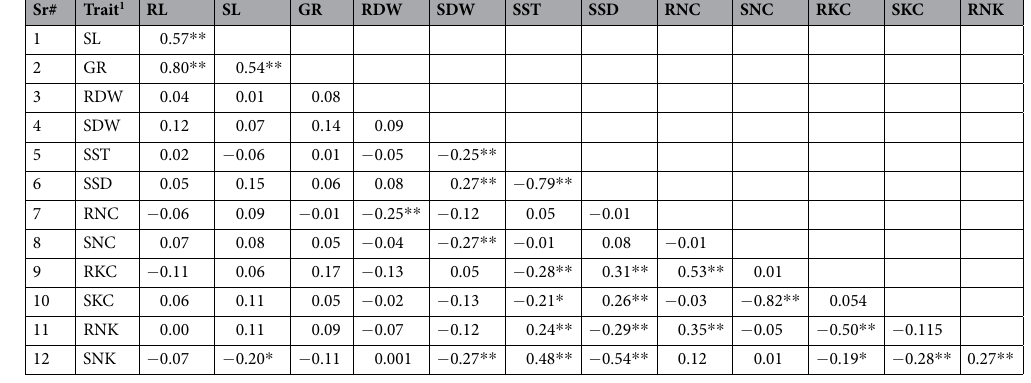
Table 2. Pearson’s co-efficient of correlation for salt tolerance related traits measured at the germination and seedling stages under salinity. 1 Same as in Table 1. * and ** represents significance at P < 0.05 and P < 0.01, respectively.